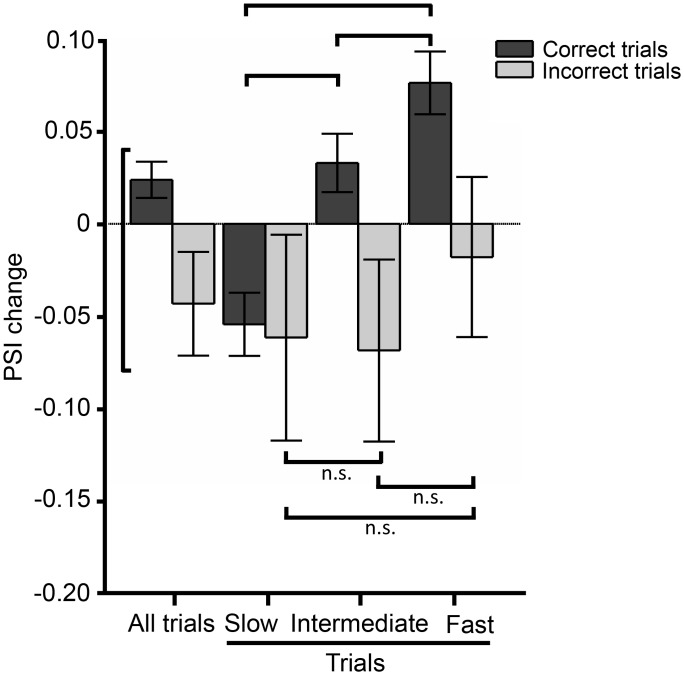
PSI change on correct versus incorrect trials.Comparison between PSI change for correct and incorrect trials. Left plot: all trials. Additional plots: similar to Fig 5C, trials were divided into three groups—slow, intermediate and fast—based on the touch duration. Mean values of PSI change are plotted for each group. Error bars are standard error of the mean. Black lines indicate one-tail t test comparison between groups, * indicates p < 0.05, n.s. indicates p > 0.05. All data are available at http://figshare.com/s/99b31b8a567f11e5b81d06ec4bbcf141.